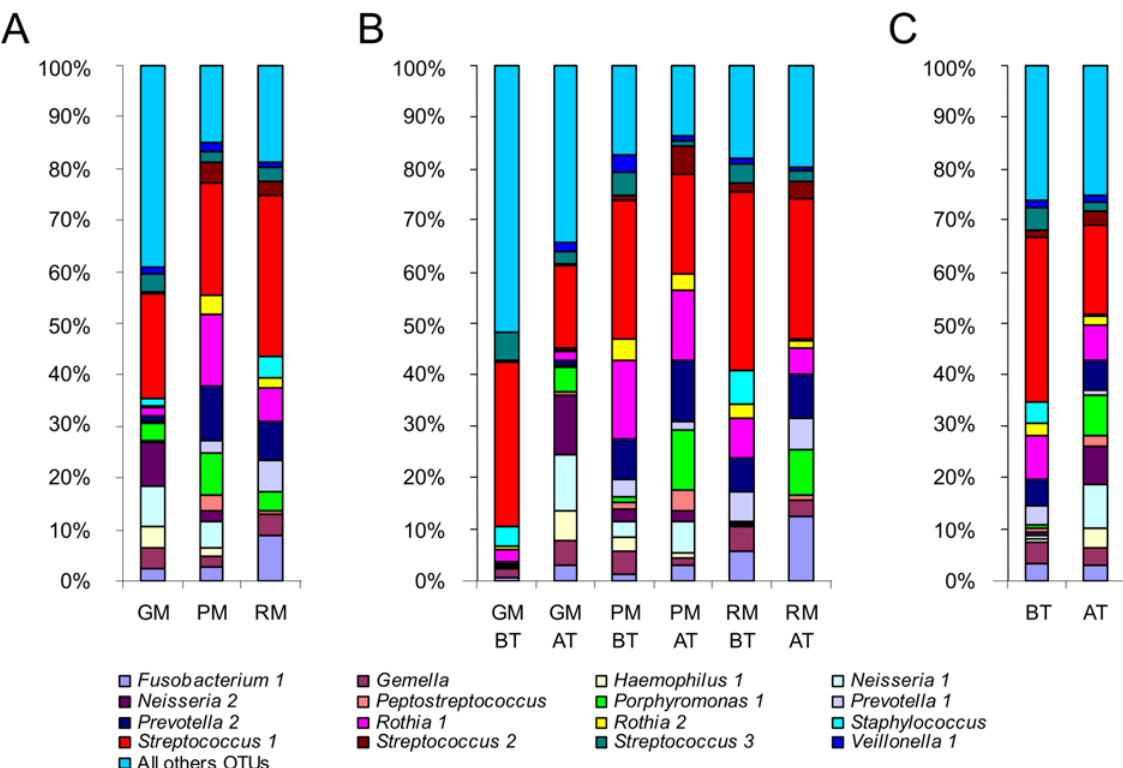
Fig 1. Relative abundance (RA) of OTUs belonging to the major core microbiota. A) RA of OTUs for the three patients (GM, PM, and RM) highlighted that each individual harbored his or her own microbiota, even if several genera were shared. B) RA of OTUs before ivacaftor treatment (BT) and after the beginning of ivacaftor treatment (AT) for each patient. RA of Streptococcus 1 showed a tendency to decrease from BT to AT samples, whereas Porphyromonas 1 increased. C) Grouping all BT samples (on the left of the graph) and all AT samples (on the right of the graph) confirmed the tendency observed per patient: after ivacaftor treatment, the RA of Streptococcus 1 decreased while that of Porphyromonas 1